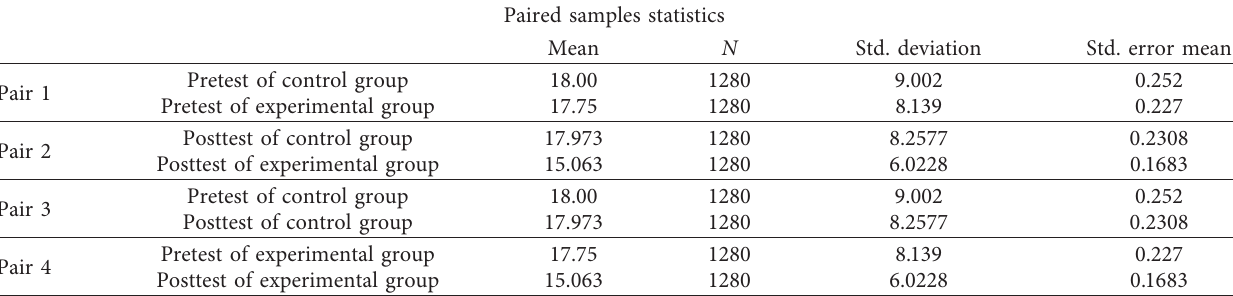
Table 2: Paired samples statistics.